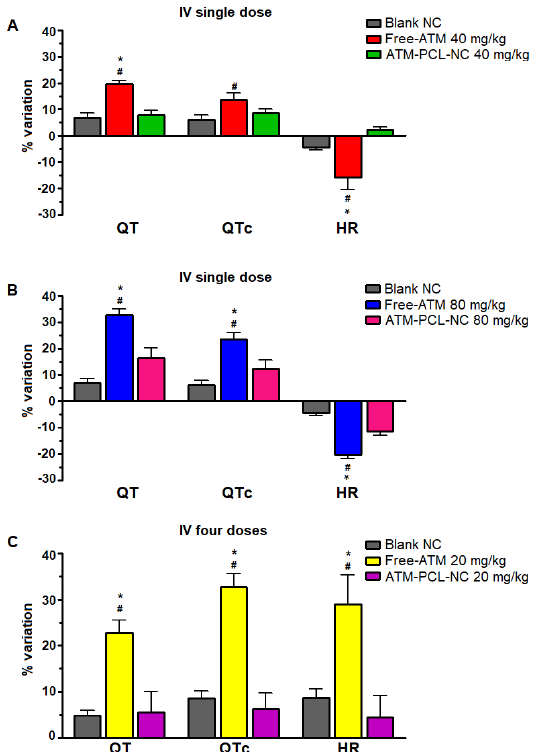
Figure 7. Maximal percentual variation of QT and QTc intervals and heart rate (HR) after IV admin- istration of blank-NC, free-ATM, and ATM-PCL-NC, a single dose of 40 ( A ) and 80 mg/kg ( B ), and four doses (one every 12 h) of 20 mg/kg ( C ). * p > 0.05 compared to blank-NC and # p > 0.05 compared to ATM-PCL-NC administration. ANOVA followed by Tukey post-test.